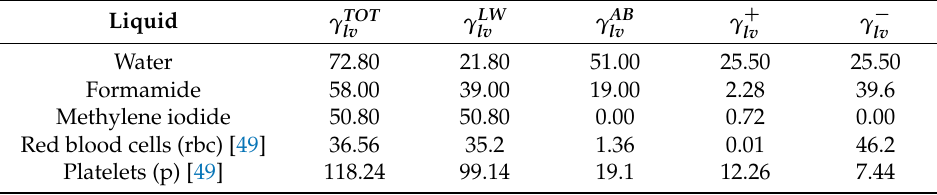
Table 2. Surface tension parameters (mN/m) of the liquids used for contact angle